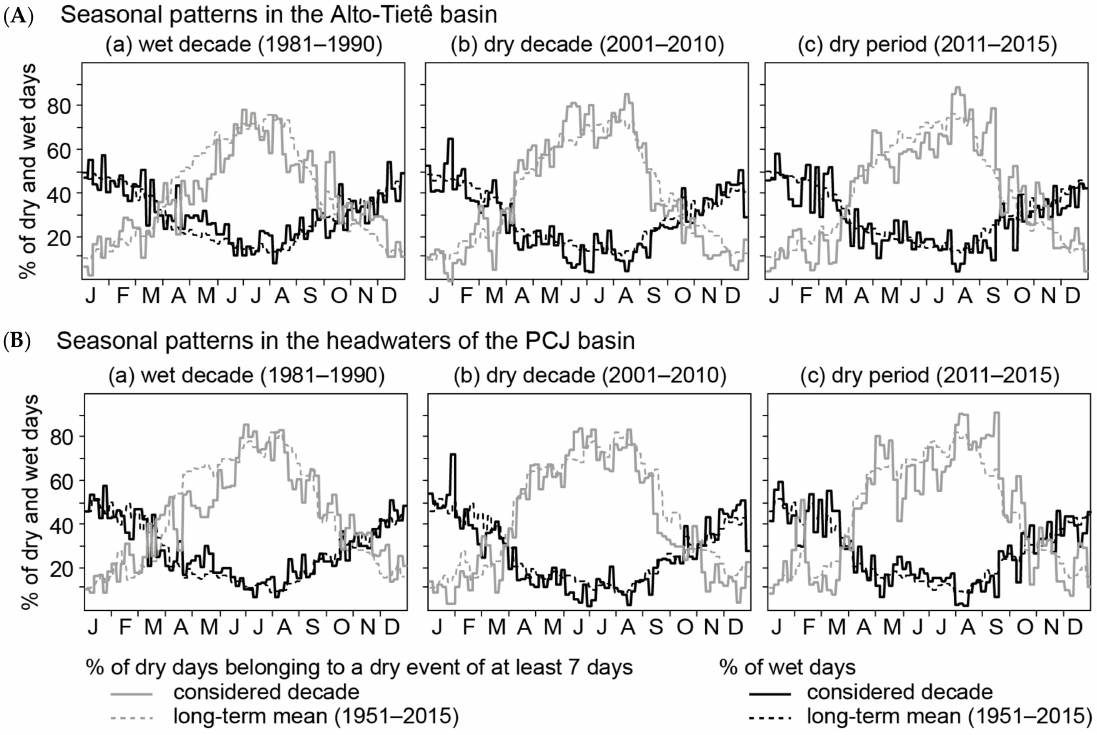
Figure 4. Specific precipitation seasonal patterns that emerged from the 1951–2015 average in ( A ) the Alto-Tiet ê and ( B ). PCJ basins: ( a ) wet decade (1981–1990) due to more wet days and less dry days during the dry season, ( b ) dry decades (1971–1980 and 2001–2010) due to more dry days during the wet season, and ( c ) dry period (2011–2015) due to a longer and more intense dry